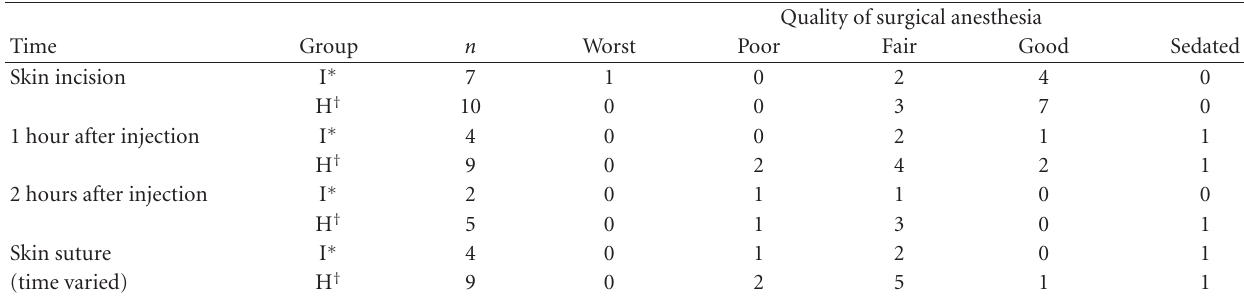
Table 4: Quality of surgical anesthesia graded by patients at incision time, at 1 hour and 2 hours after injection of local anesthetic, and at skin suture time. The intervals between skin incision and suture time in isobaric and hyperbaric groups were [min–max] [51–135] minutes and [45–213] minutes, respectively. Values are number of